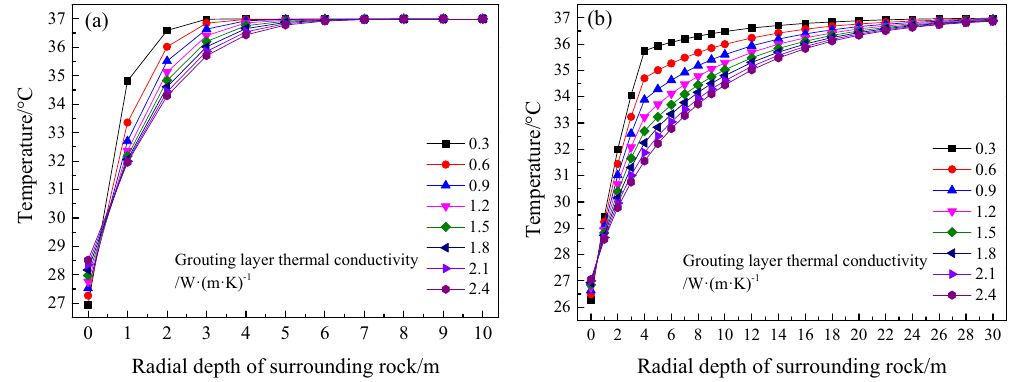
Figure 10: Influence of grouting layer thermal conductivity on surrounding rock temperature field: ( a ) 30 days; ( b ) 1,095 days.